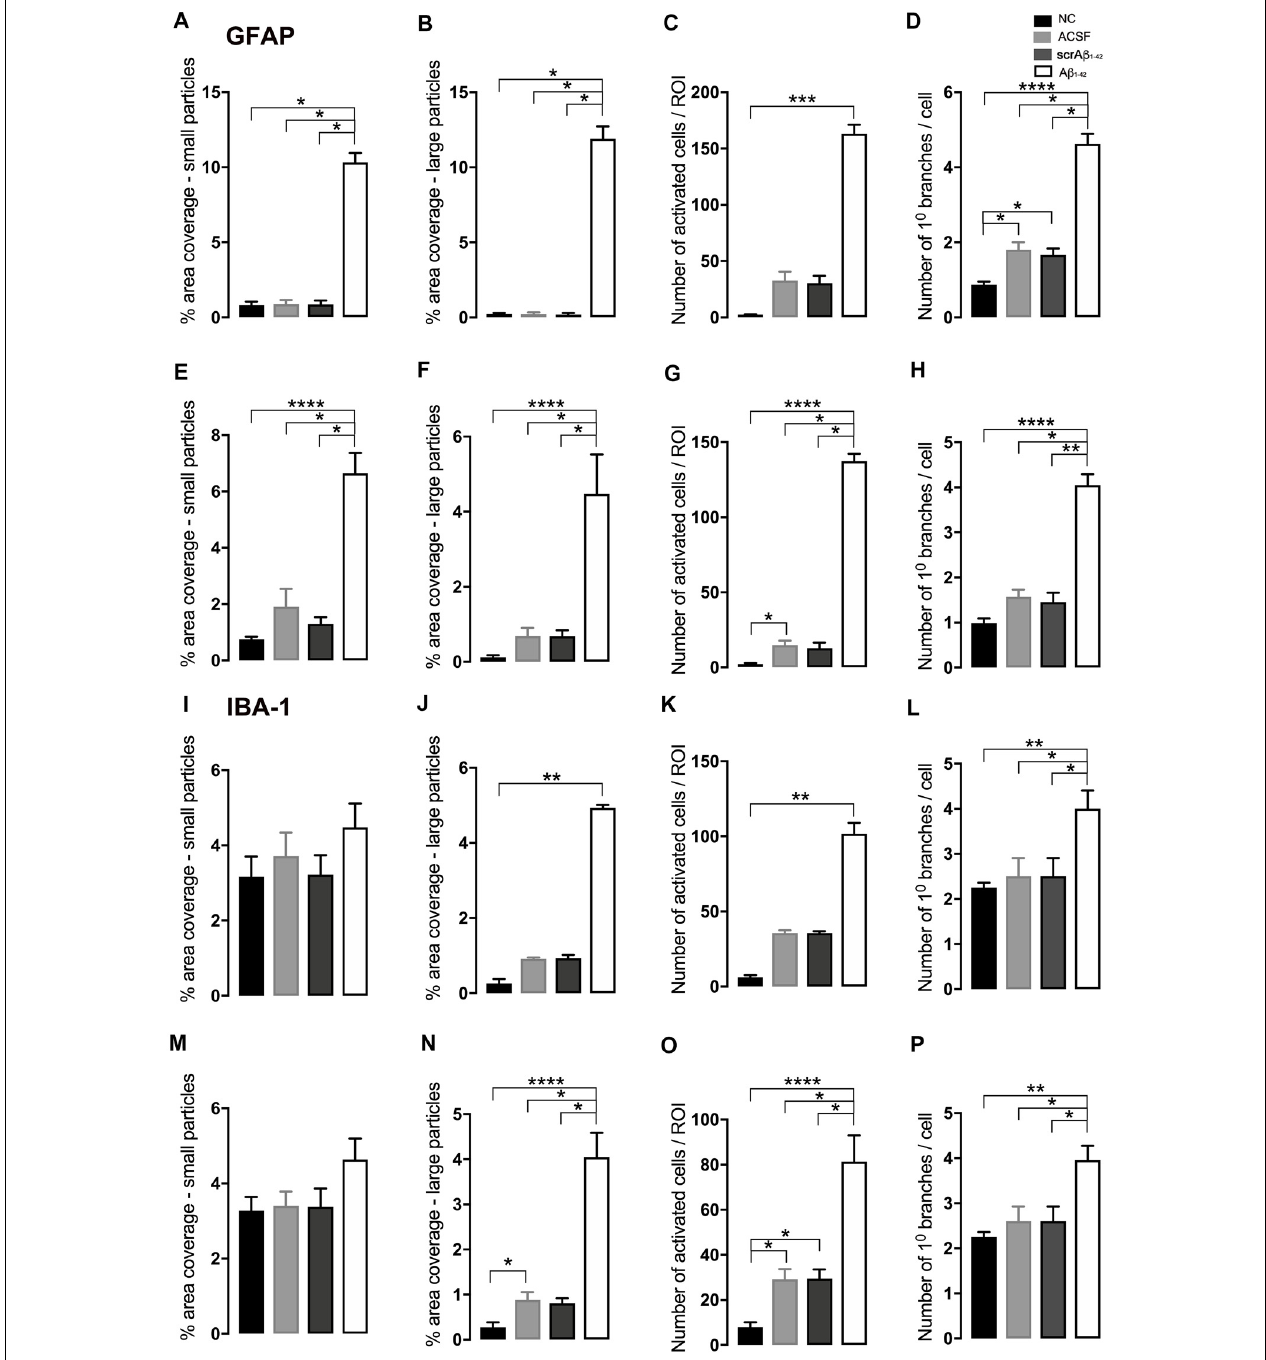
FIGURE 2 | Graphs showing quantification of astrocytic and microglial morphology at the injection site (A–D,I–L) and a location adjacent to the injection site (E–H,M–P) in the CA1 hippocampal region 3 days post-injection in NC, ACSF-, scrA β 1–42 - and A β 1–42 -injected mice. Data expressed as mean ± SEM (Kruskal–Wallis test; * p < 0.05; ** p < 0.01, *** p < 0.001, **** p < 0.0001, n = 3–6).